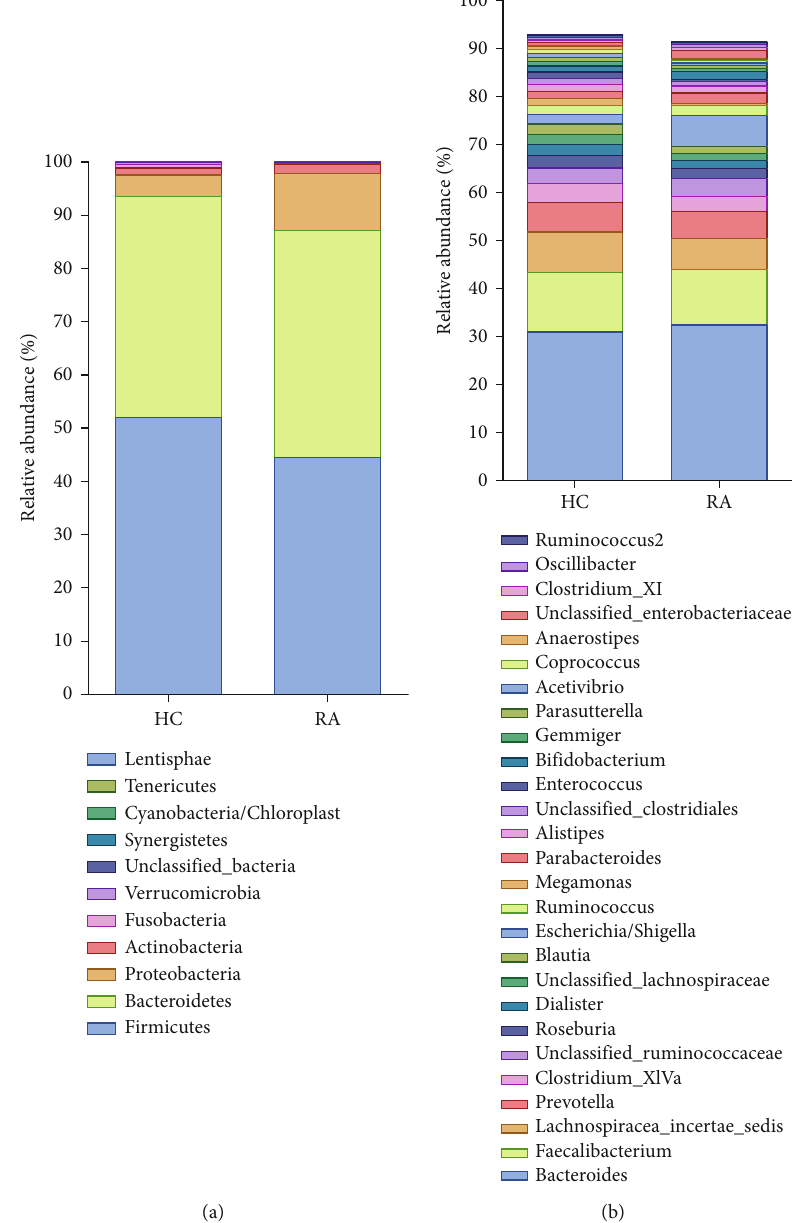
Figure 2: Microbiota composition of healthy controls and RA patients at the phylum (a) and genus (b)